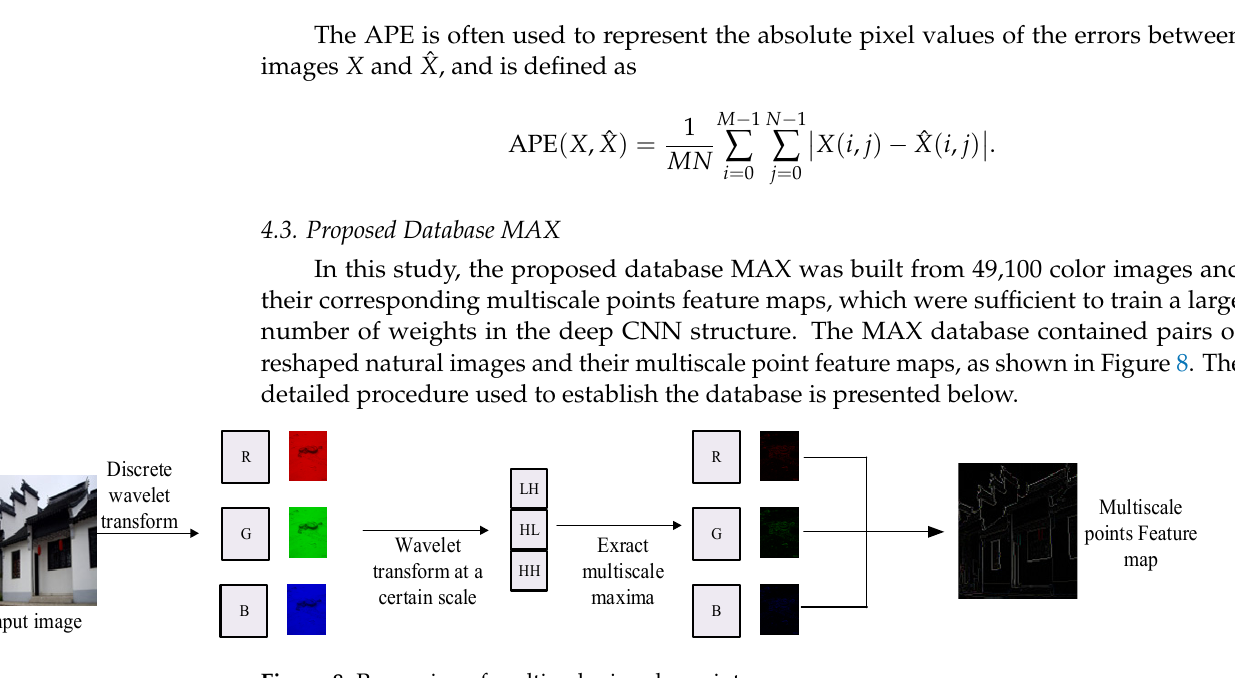
Figure 8. Processing of multiscale singular points map.